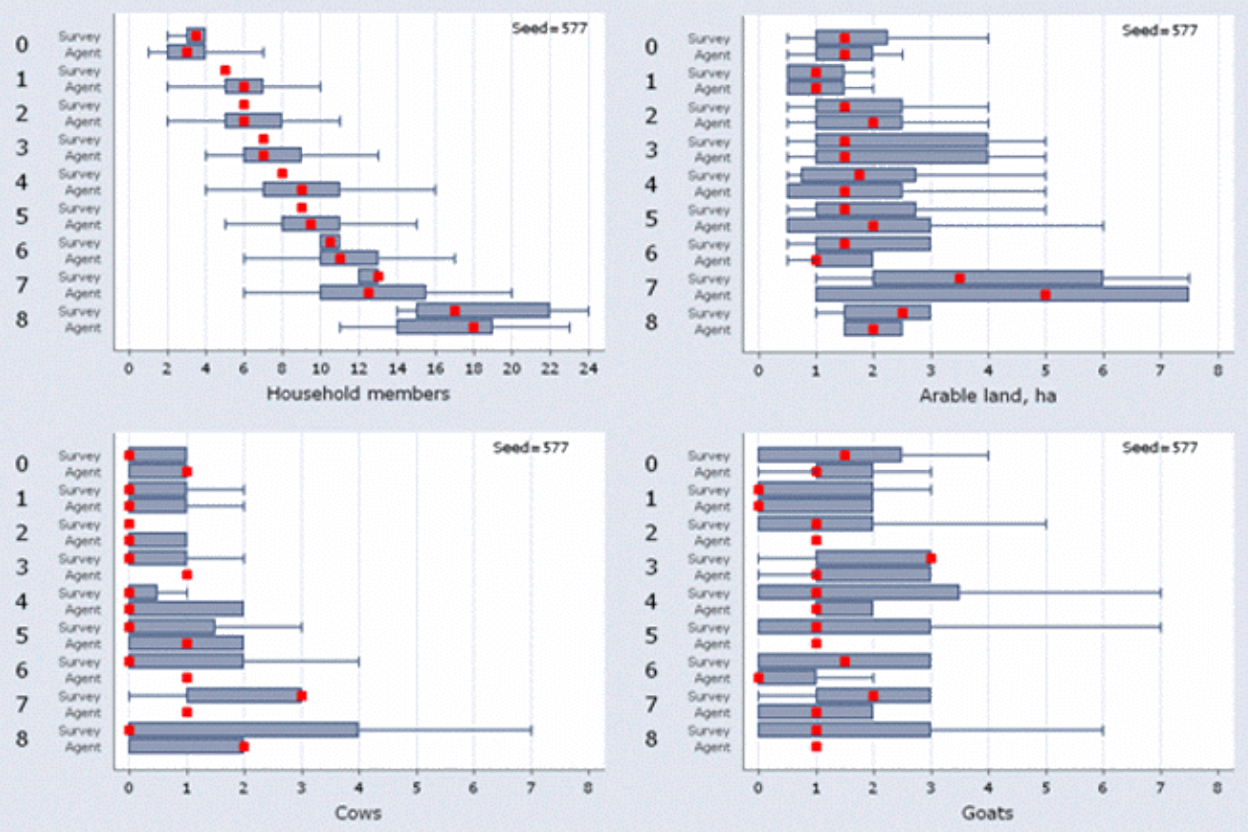
Fig. 6. Boxplots for the distribution of the four major resources over